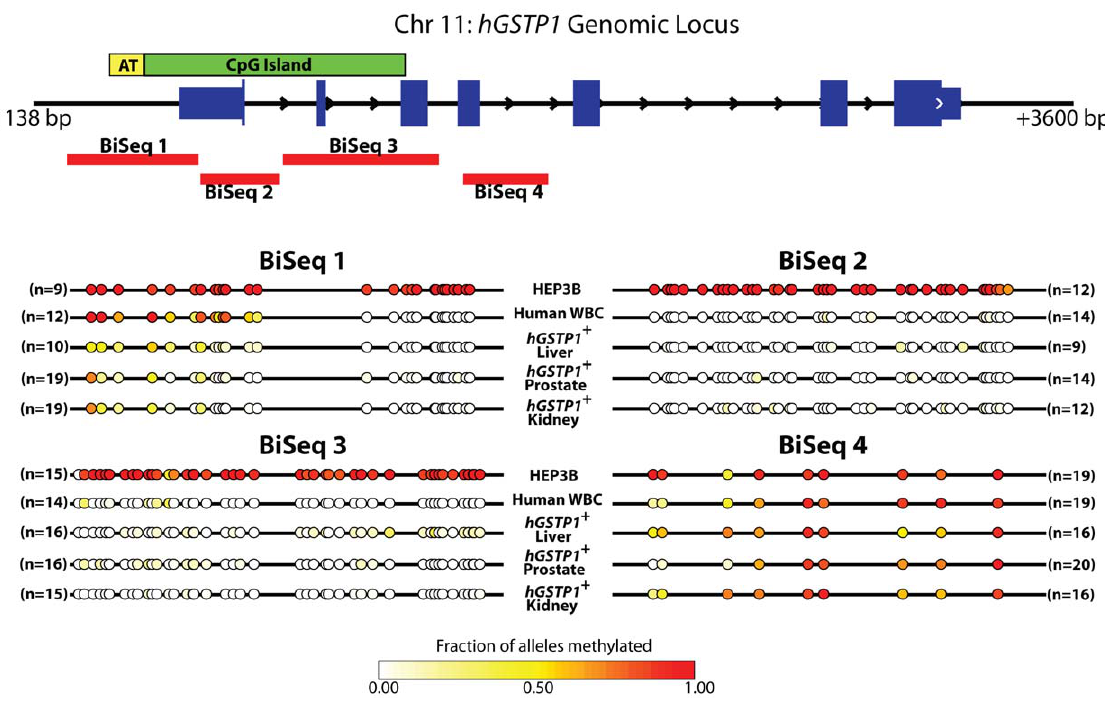
Figure 3. The hGSTP1 transgene in hGSTP1 + mGstp1/2 2 / 2 mice recapitulates the pattern of methylation seen in normal human cells. Bisulfite genomic sequencing for 5-me C in four amplicons (labeled BiSeq 1–4)from the hGSTP1 CpG island using DNA from various hGSTP1 + mGstp1/2 2 / 2 mouse tissues ( hGSTP1 + liver, prostate, kidney), along with DNA from human white blood cells (normal hGSTP1 5-me C pattern) and Hep3B cells (hypermethylated at hGSTP1 CpG island). Each row represents a summary of multiple independently cloned alleles from each sample as indicated. Circles indicate the relative position of CpG dinucleotides within the bisulfite sequencing amplicon. The color of each circle is scaled to the fraction of alleles methylated for the indicated CpG according to the heatmap shown at the bottom.